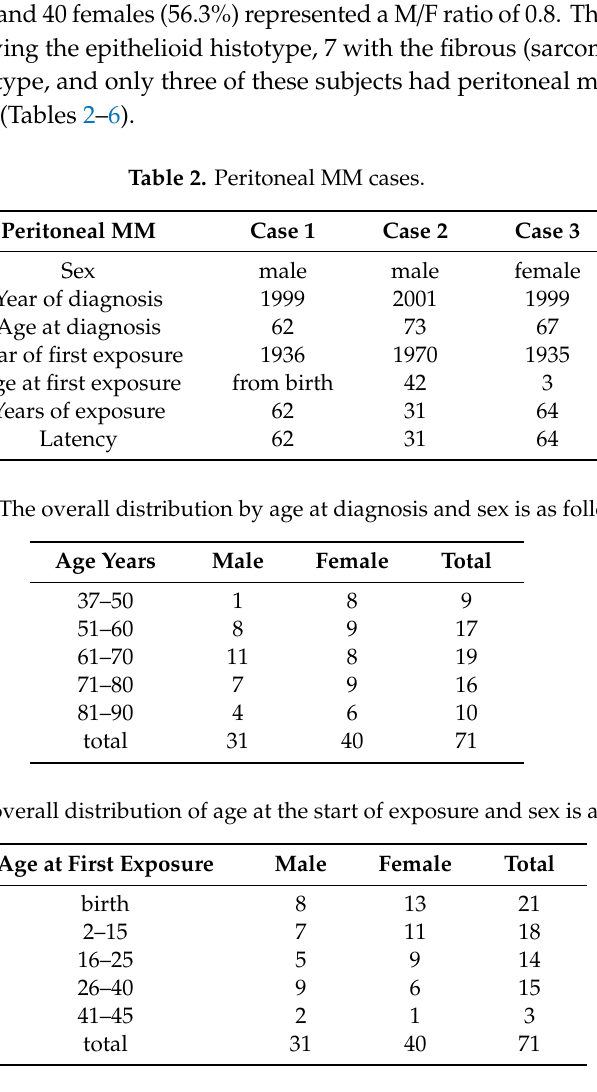
Table 5. The overall distribution by latency and sex is as